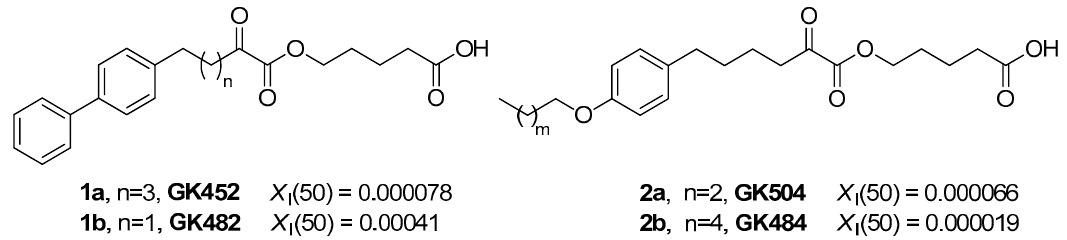
Figure 1. Known 2-oxoester inhibitors of GIVA cPLA 2 [23,24].